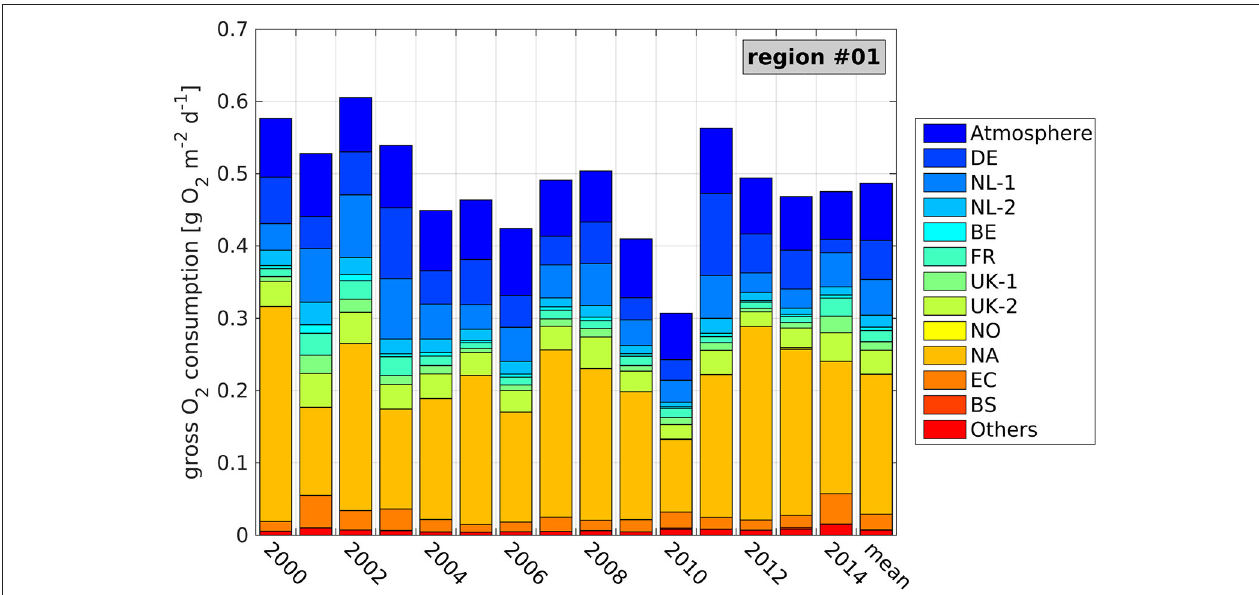
FIGURE 7 | Average daily, near-bottom gross O 2 consumption (GOC) during seasonal stratification and contributions of the different N sources (see Table 1 ) at the ODZ site (see Figure 5 , region 1) during the individual years 2000–2014, and averaged over the entire period. Values refer to a bottom layer thickness of 6.5m.